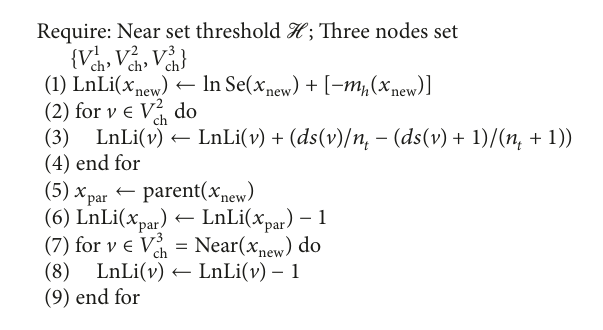
Algorithm 3: Update liveness